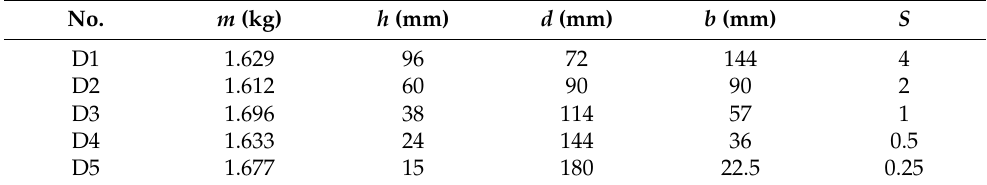
Table 2. Drop hammer mass and